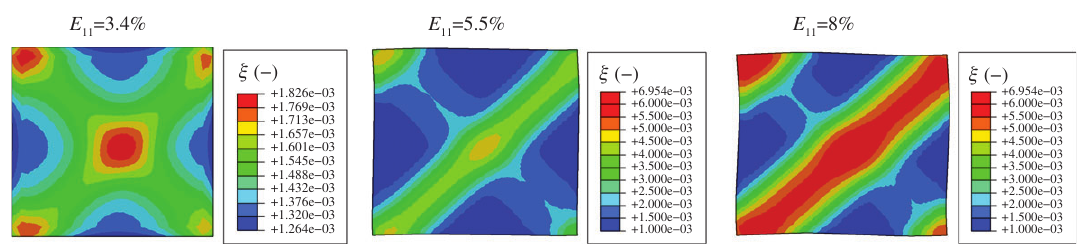
Figure 14 Sample S , variation of initial defect: spatial distribution of free volume ξ at different applied strains E 2 Initial defect near the center (see Figure 16).